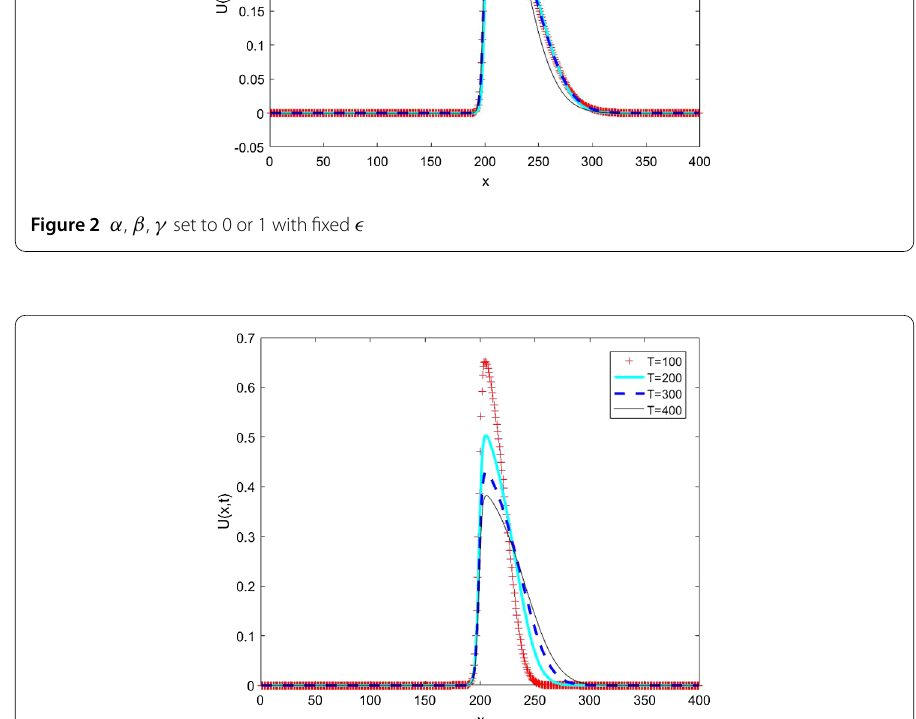
Figure 3 Time evolution of the solution for α = β = γ = (cid:4) =